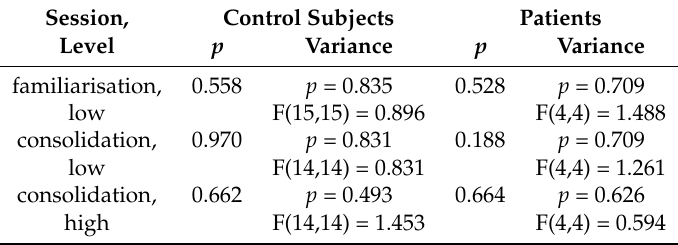
Figure 7. SR for the Myo-Pong at high difficulty during the consolidation session . C10 did not play in this session. Table 3. SR comparison between flexor and extensor carpi radialis in the familiarisation session and in the consolidation session , with two levels of difficulty: Low and